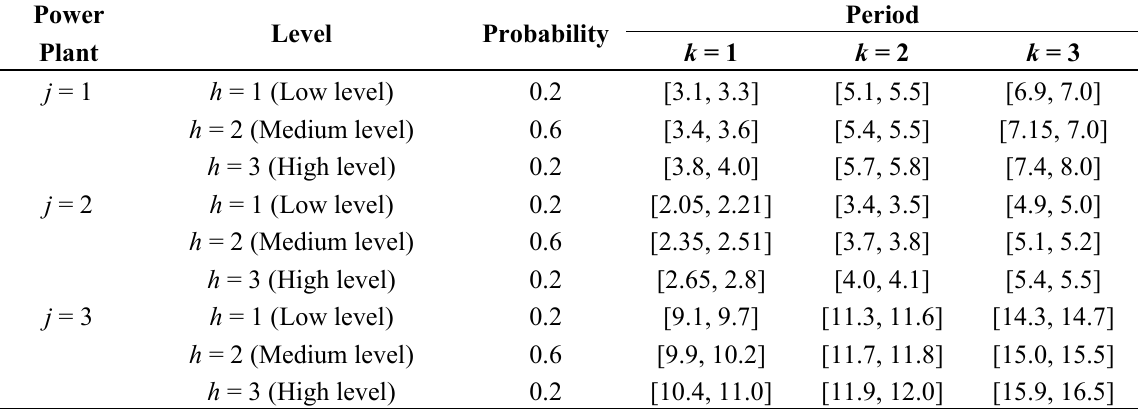
Table 1. Power-generation demands under different probability levels (10 8